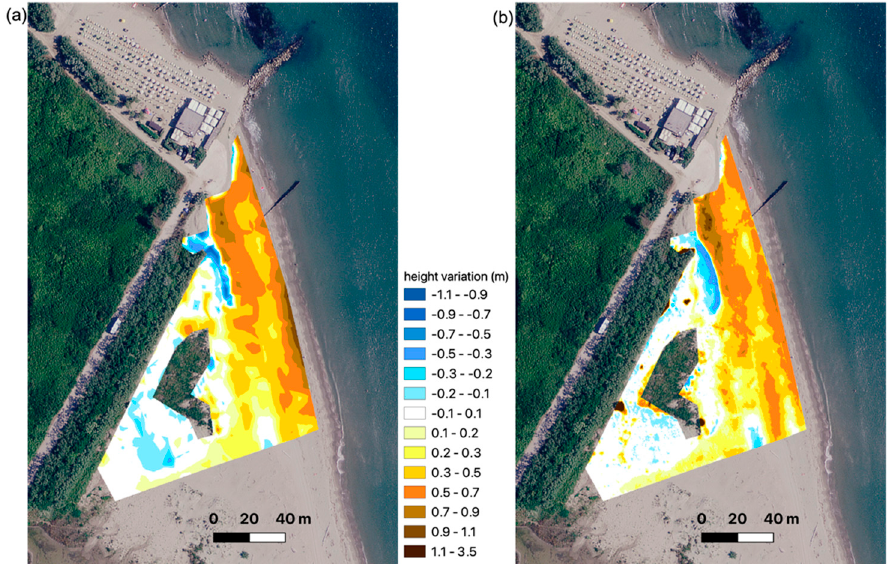
Figure 8. Maps of height variations between 2019 and 2020, for GNSS ( a ) and photogrammetric UAV surveys ( b ).